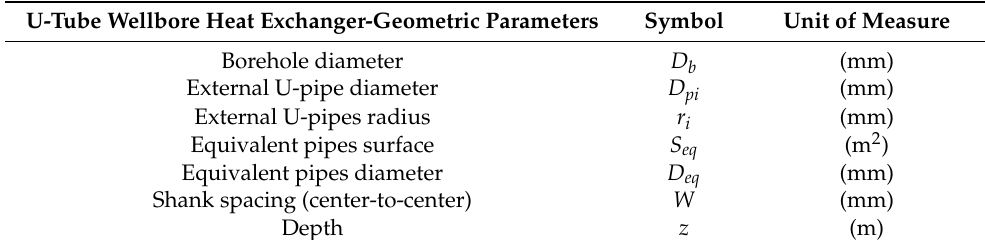
Figure 3. Thermal resistances definition steps: ( a ) borehole resistance, ( b ) parallel borehole re- sistances, ( c ) convective and conductive resistances and ( d ) final resistances configuration (repro- duced from [22]. Copyright Elsevier, 2014).